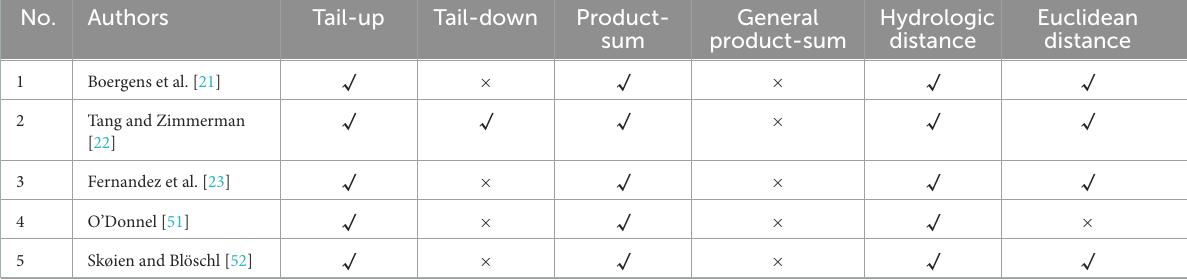
TABLE 7 Spatio-temporal product-sum hydrologic distance methods used in